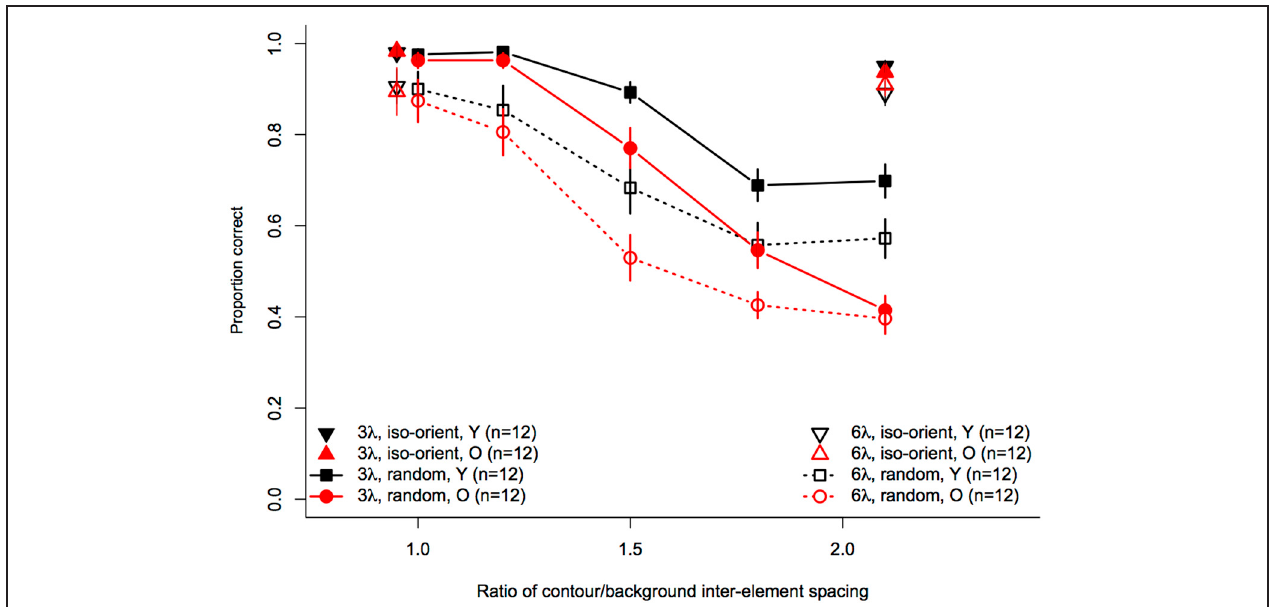
FIGURE 8 | Experiment 3 results: contour discrimination accuracy is shown as a function of relative contour and background spacing. Data for the iso-oriented background conditions are shown by the triangle symbols (up, black for younger subjects and down, red for older subjects) that are